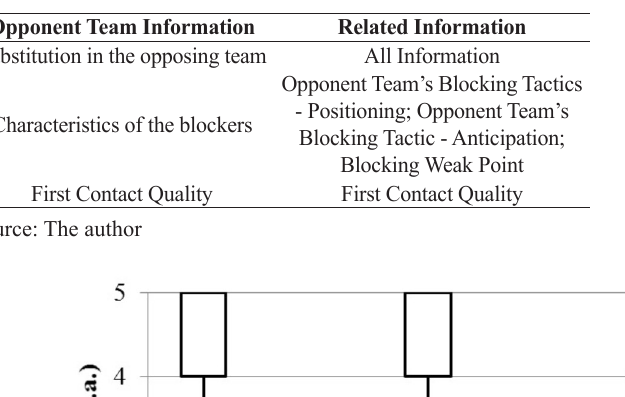
Table 7: List of information related to the setter’s opposing team complemented by the coaches with the information included in the questionnaire during the Counterattack Processes.